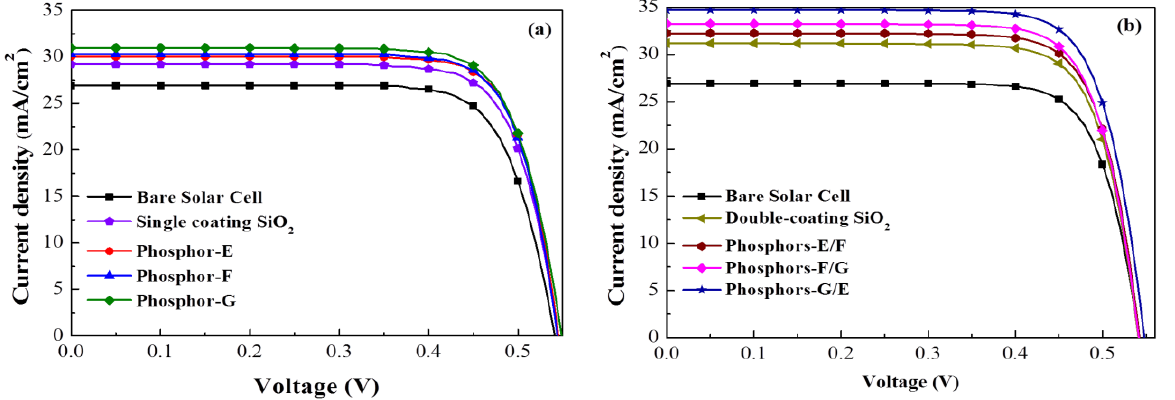
Figure 9. J – V curves of silicon solar cells: ( a ) single coating; ( b ) double coating, under AM 1.5 G simulation.